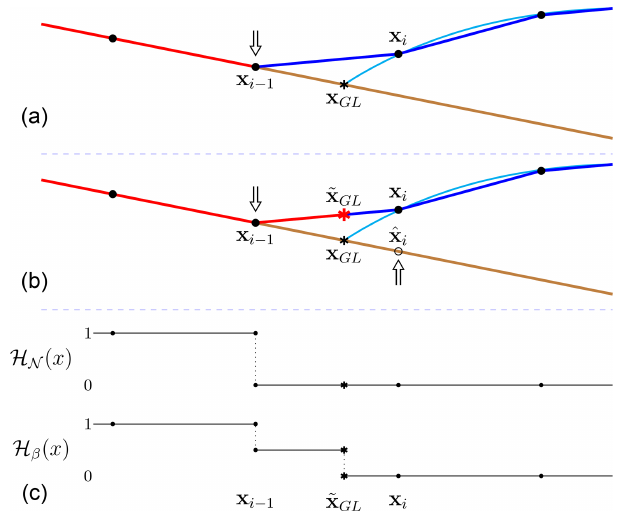
Figure 3. Schematic figure of the GL in case ii, with the arrows in- dicating the direction of the net forces in the vertical direction. The colors of the lines follow those in Fig. 2. (a) The last grounded and first floating nodes as defined in Elmer/ICE. The node x i is fully geometrically floating, and the net force is 0. (b) Linear interpola- tion to approximate the numerical GL position ˜ x GL . The point ˆ x i on the bedrock has the same x coordinate as x i . (c) The step func- tions H N (x) and H β (x) indicate the area for Nitsche’s penalty and slip boundary